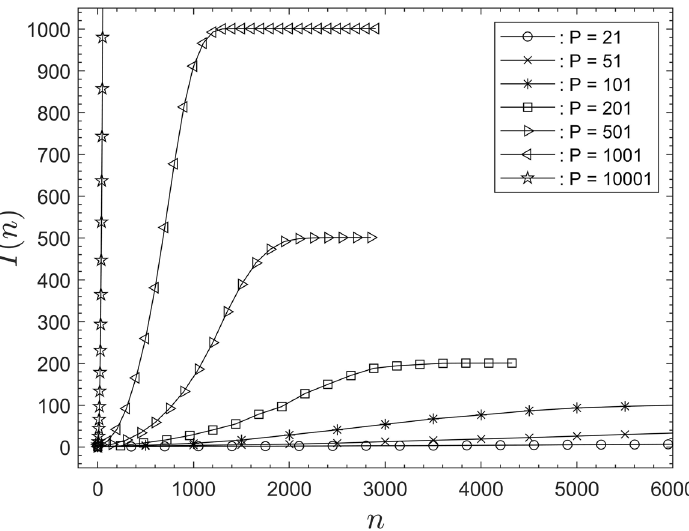
Figure 1. Raw data for the number of infected people, I ( n ) , as a function of the iteration step, n , for seven different, individual simulations and population sizes P . Only a fraction of the available data points, for each population size, are shown.